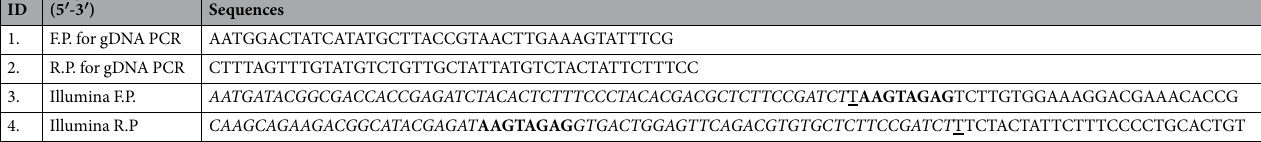
Fig. S1C,D). PCR reactions were pooled together and resolved (with 6X DNA Gel Loading Dye) at 100 V for 1 hour in a Gel Electrophoresis Apparatus using 2% low-melting UltraPure ™ Agarose gel stained with SYBR ®